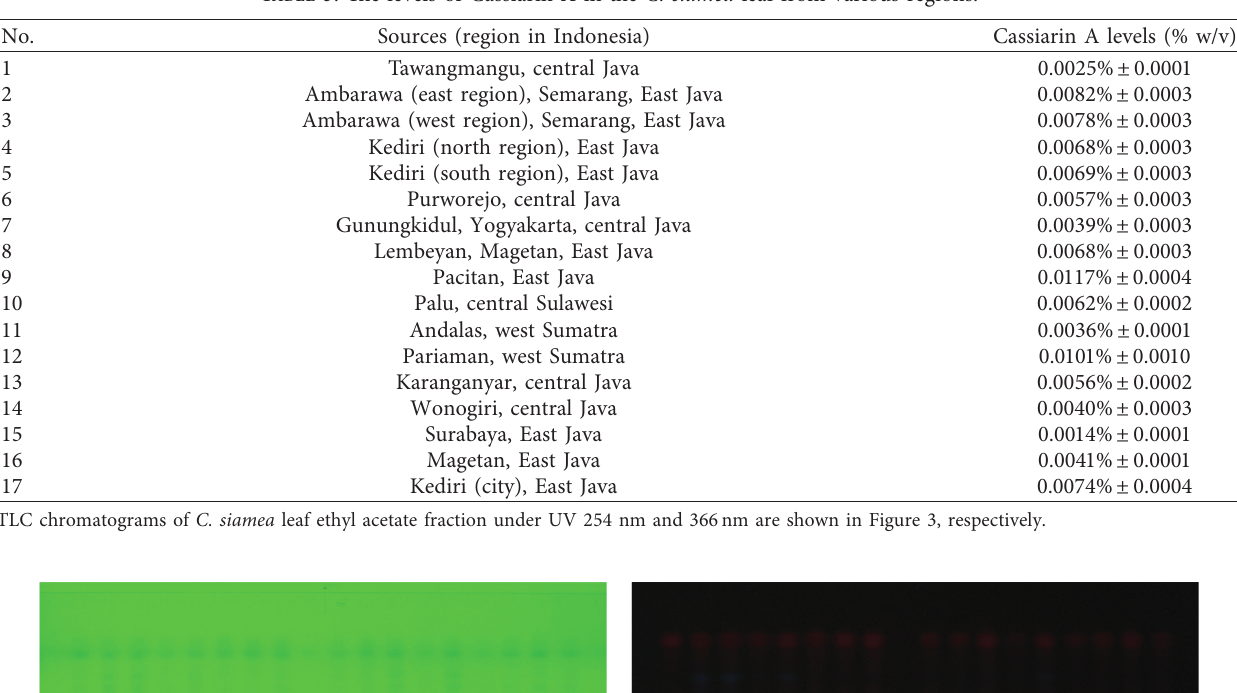
Table 3: The levels of Cassiarin A in the C. siamea leaf from various regions.